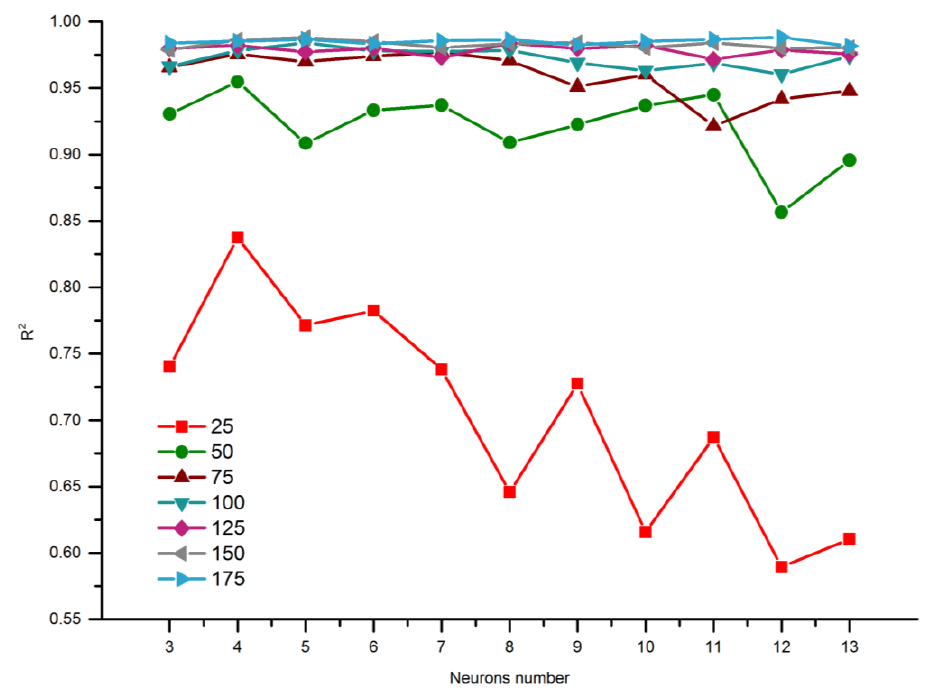
Figure 5. R 2 in di ff erent node numbers and training group Figure 5. R 2 in different node numbers and training group sizes.